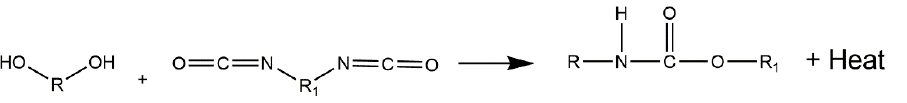
Figure 1. Schematic representation of the reaction between a polyol and a diisocyanate to form the urethane linkage.